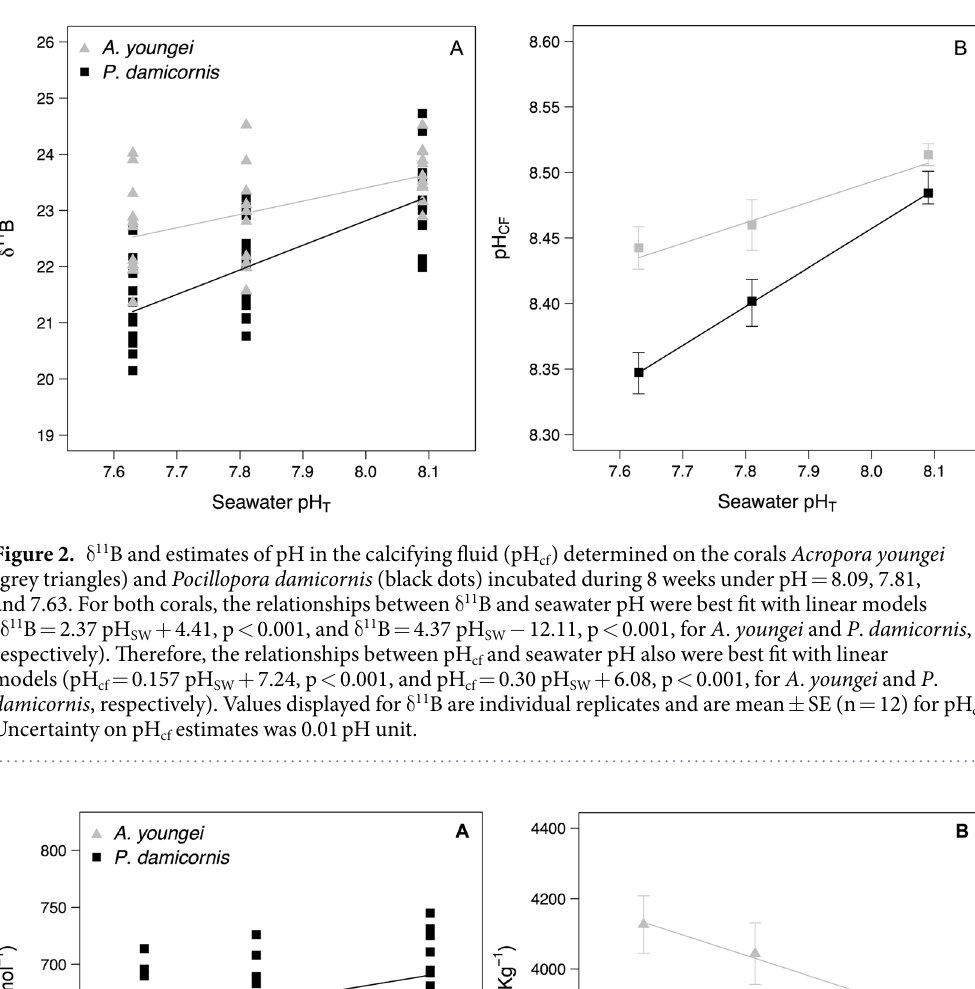
youngei followed the equation pH cf = 0.157 pH SW + 7.24. For P . damicornis , seawater pH also significantly affected δ 11 B (p < 0.001) that decreased linearly with decreasing seawater pH ( δ 11 B = 4.37 pH available in the supplementary Table 2). As a result, pH cf of P . damicornis also decreased linearly with seawater pH (pH cf = 0.30 pH SW + 6.08; Fig. 2B, Table 2). Treatments significantly affected pH cf (p < 0.001), with posthoc analyzes showing that pH The B/Ca ratio varied for A . pulchra from 618 ± 6 to 591 ± 10 μ mol mol − 1 at pH 8.1 and pH 7.6, respectively,